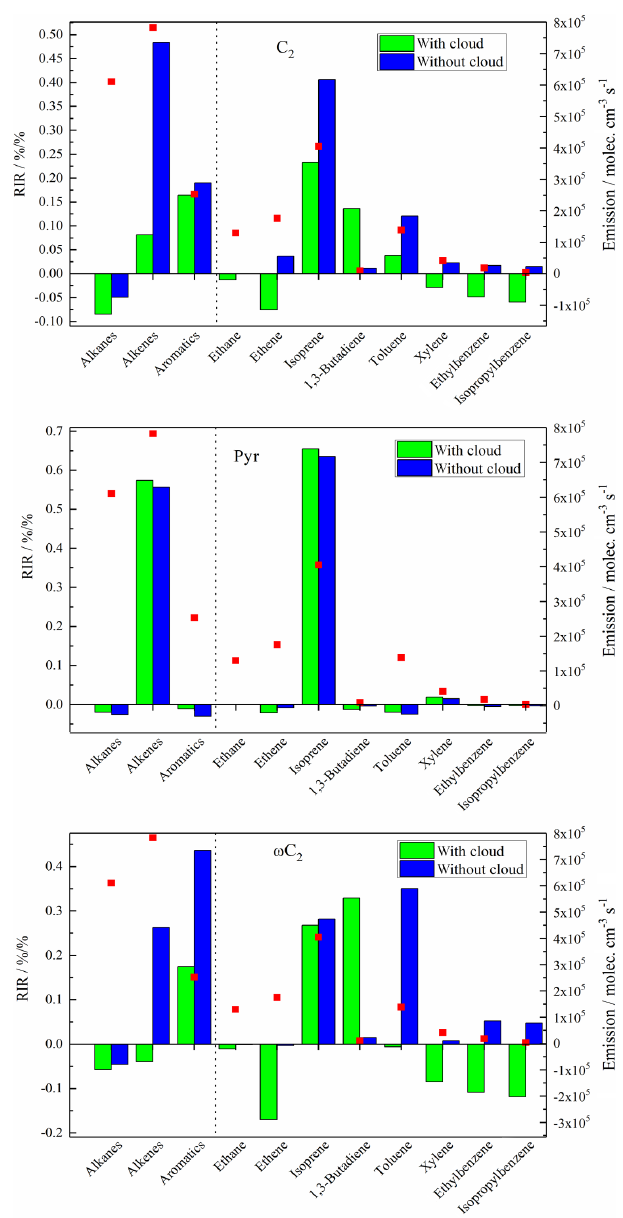
Figure 8. The calculated RIRs for C 2 , Pyr and ω C 2 in both the C2w (green bars) and C2wo (blue bars) cases at Mt. Tai (column: RIR values; red dots: emission